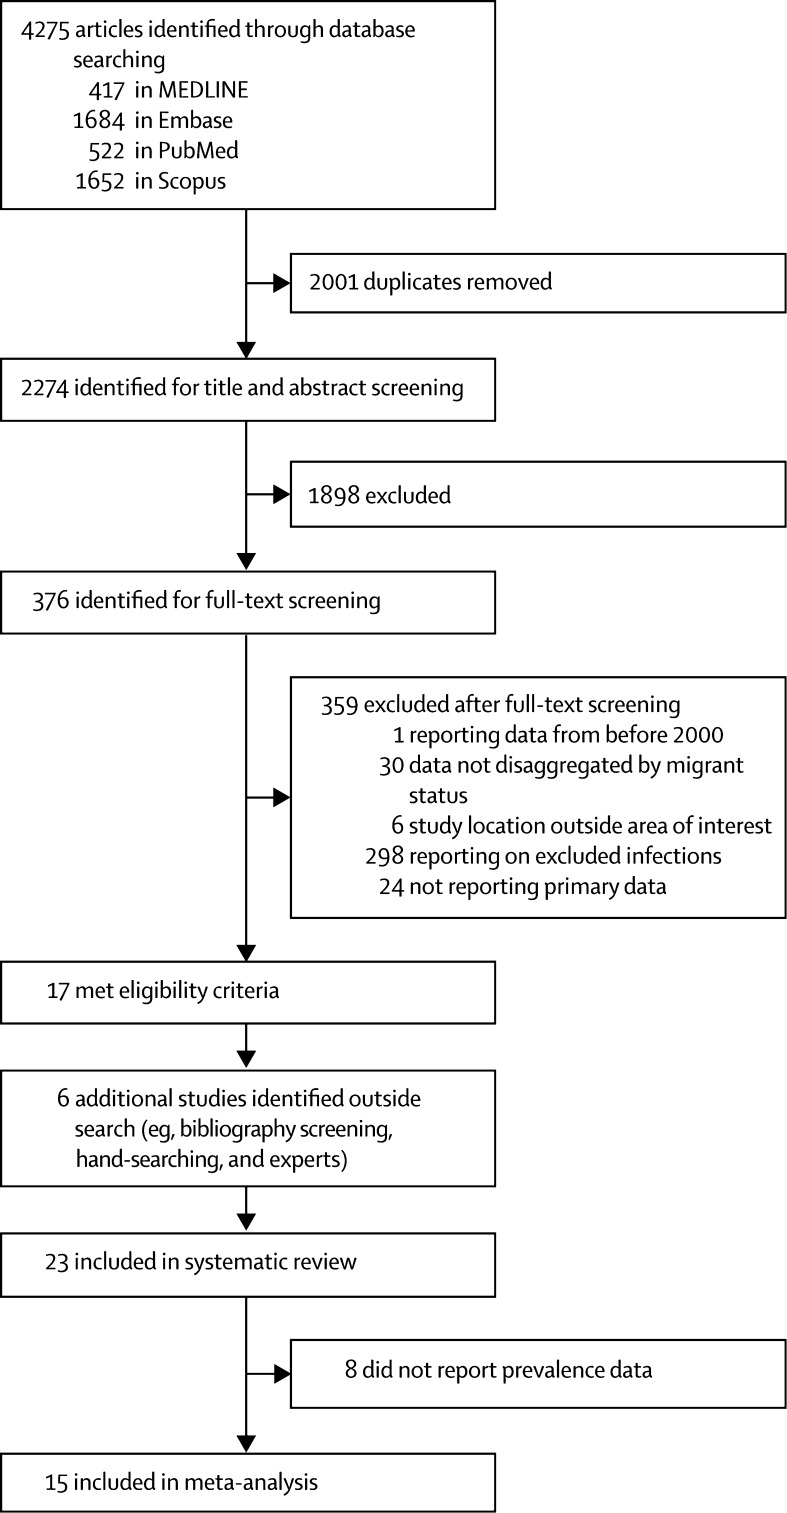
Study selection